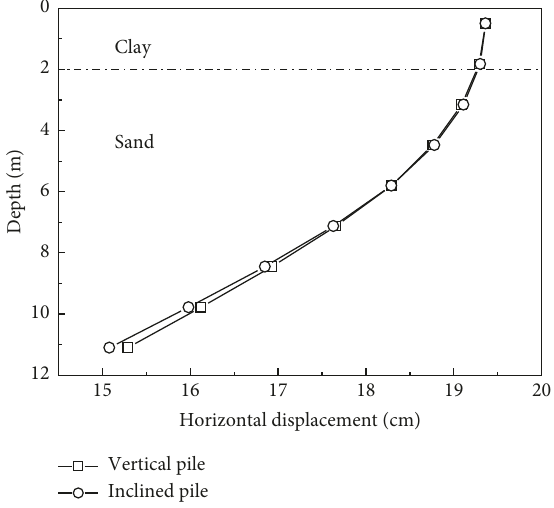
Figure 15: Horizontal displacement of the